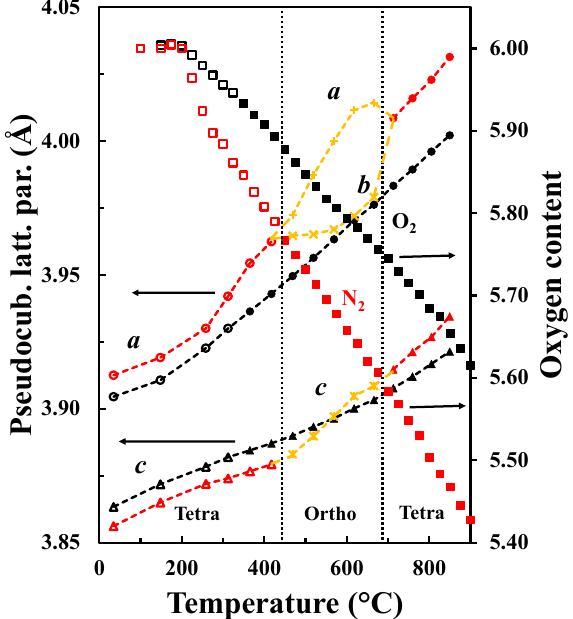
Figure 11. a (circles) and c (triangles) pseudocubic tetragonal lattice parameters as well as a (plusses), b (crosses) and c (crossed plusses) pseudocubic orthorhombic lattice parameters and oxygen content (squares) versus temperature of LaBaCo 2 O 5+ δ in O 2 (black) and N 2 (red). The transitions tetragonal-orthorhombic-tetragonal are shown. Open symbols are data out of the equilibrium. The hatched lines are guides to the eye.